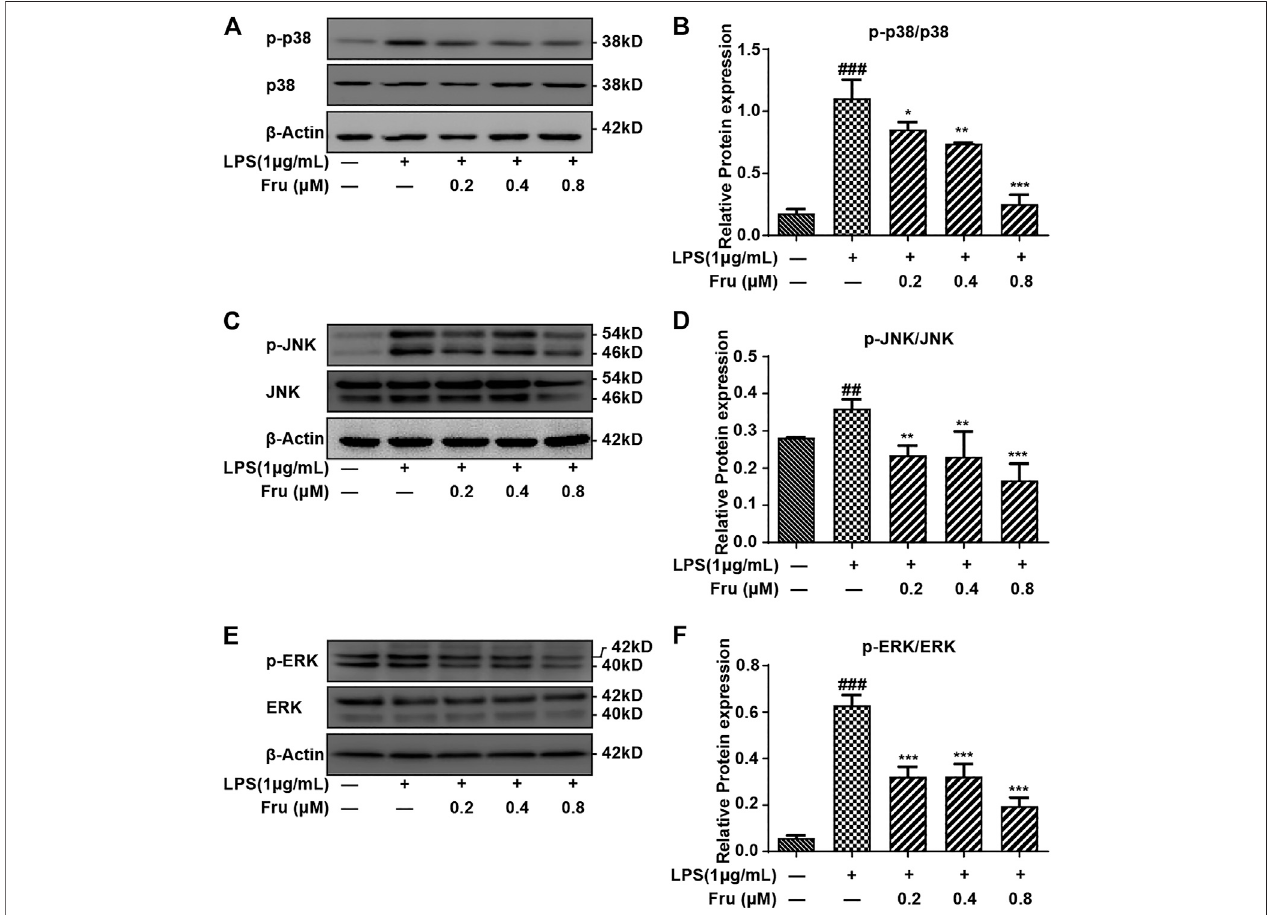
FIGURE 4 | Effect of Fru on the activation of the MAPKs pathway in LPS-induced RAW264.7 cells. The RAW264.7 cells were pretreated with different concentrations of Fru (0.2, 0.4, and 0.8 μ M) for 2 h before stimulated with 1 μ g/ml LPS for 6 h. The protein expression of p-p38/p38 (Panel (A,B) ), p -JNK/JNK (Panel (C,D) ),and p -ERK/ERK(Panel (E,F) )wasevaluatedwithWesternBlot. β -actinwasusedastheinternalcontrol.Quantitativedatawererepresentedasmean ± SD( n (cid:2) 3, ## p < 0.01, ### p < 0.001 vs. Control; * p < 0.05, ** p < 0.01, *** p < 0.001 vs. LPS).